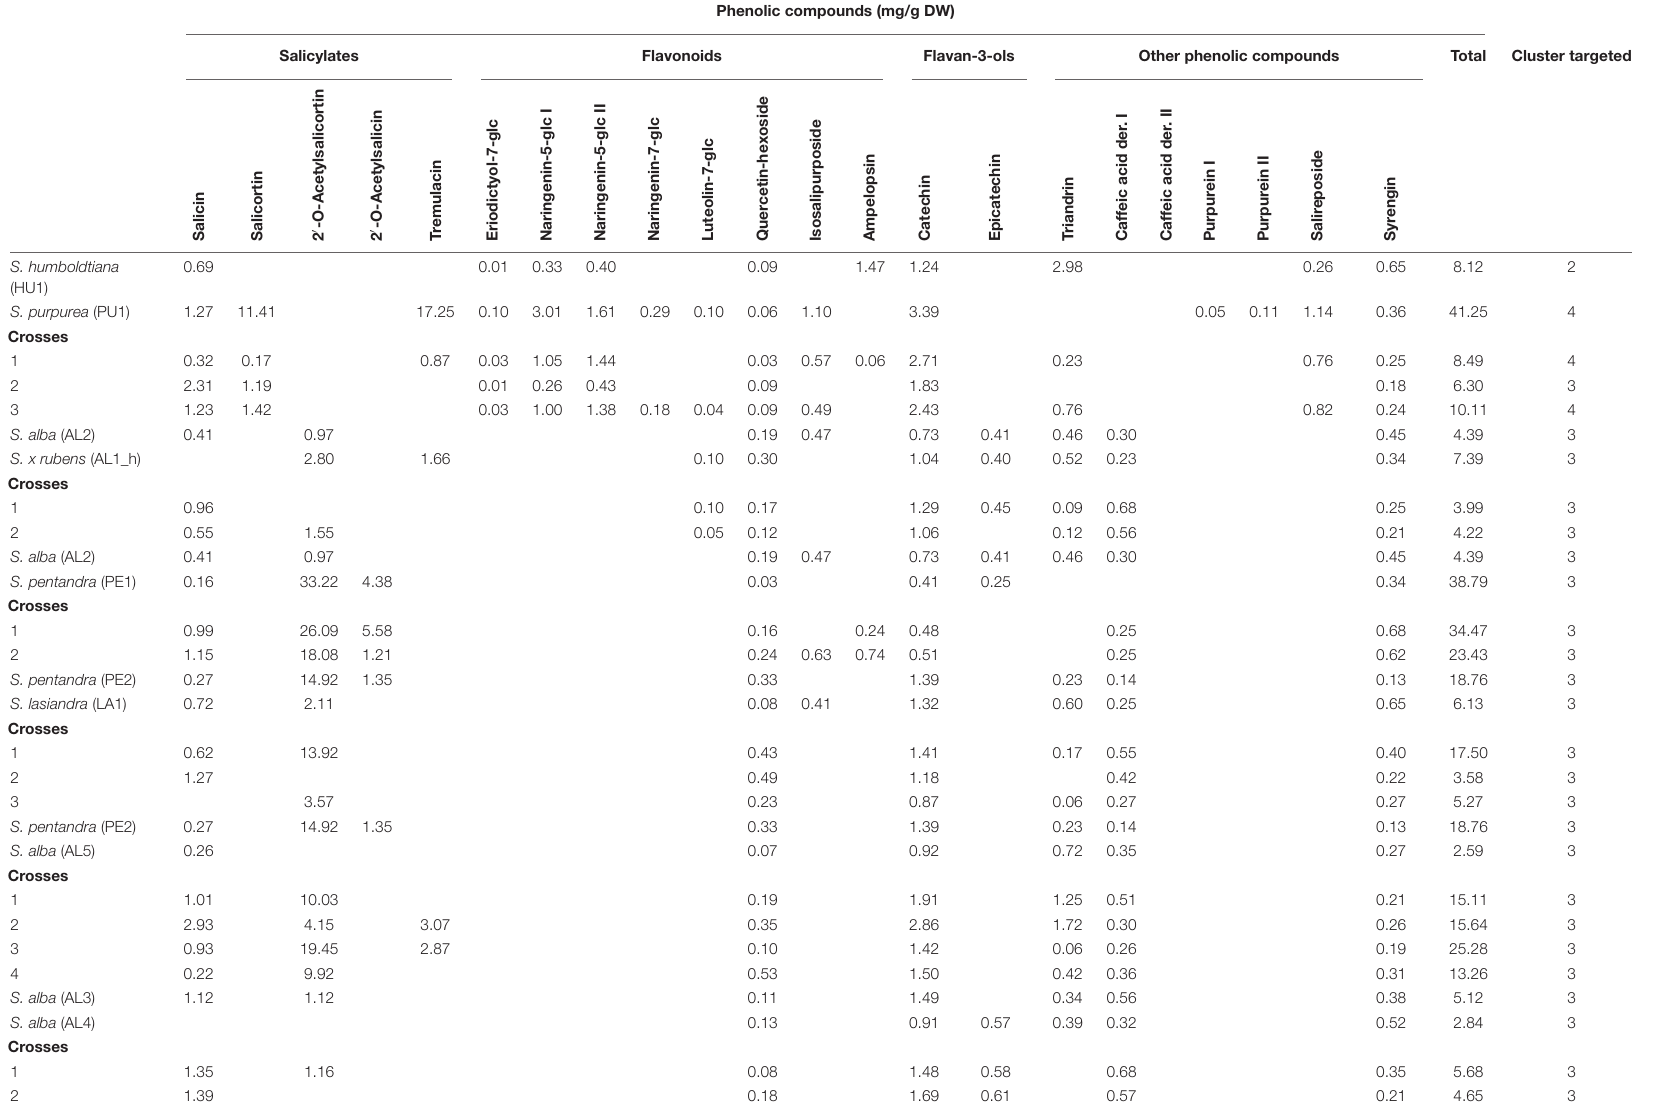
TABLE 3 | Phenolic compound profile of clones of S. alba , S. x rubens, S. purpurea , S. humboldtiana , S. lasiandra , S. pentandra , and their